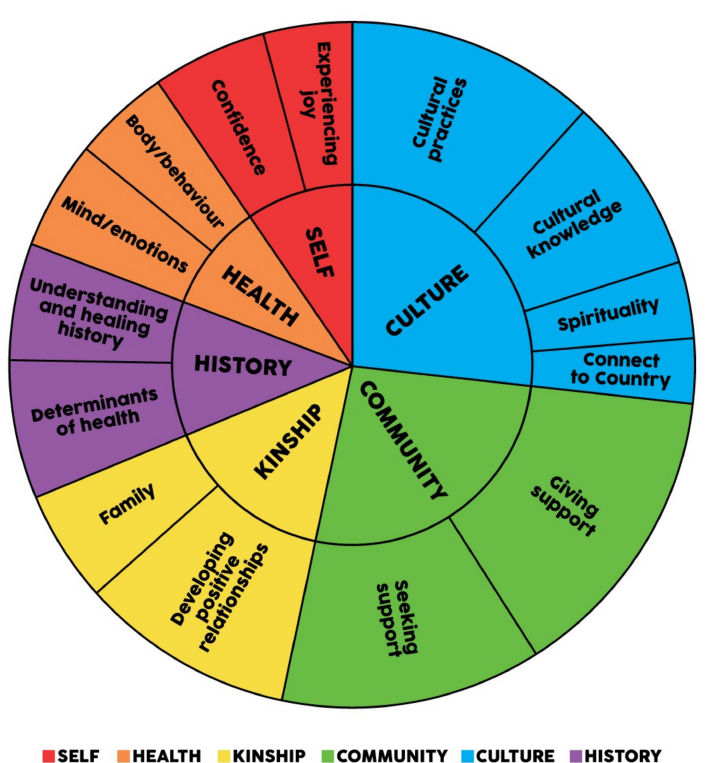
Figure 2. Thematic map of semi-structured interviews.